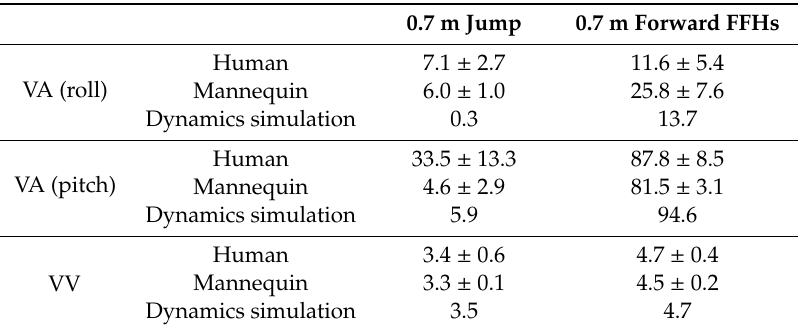
Table 5. VA ( ◦ ) and VV (m / s) determined from experiments involving humans and the mannequin and from dynamics simulations.